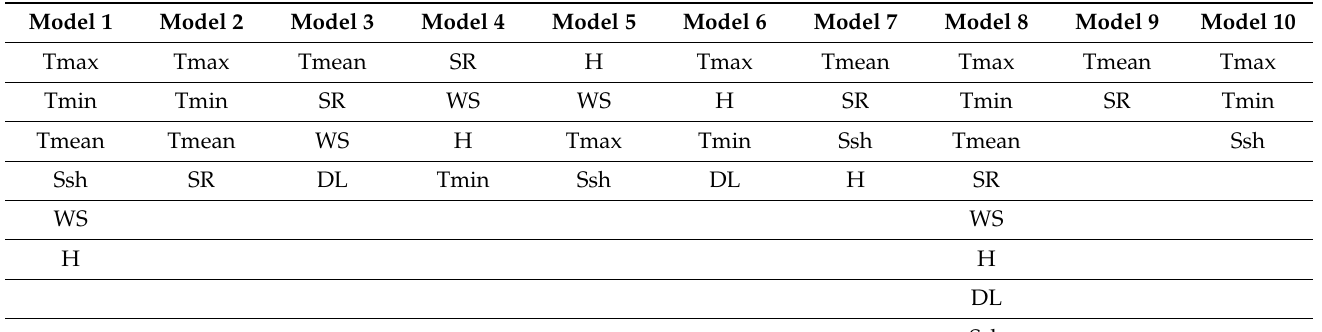
Table 1. Different combinations of input variables for model development using machine learning algorithms to estimate crop water productivity (CWP) for wheat and maize.